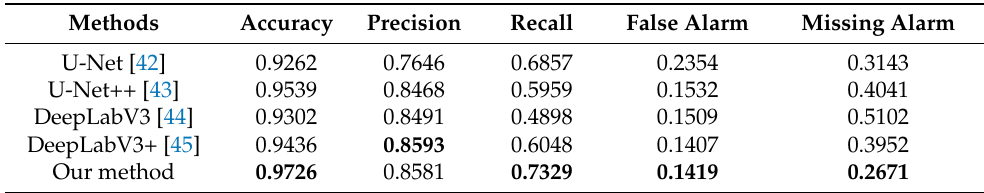
Table 3. Evaluation of other deep learning methods and our method.